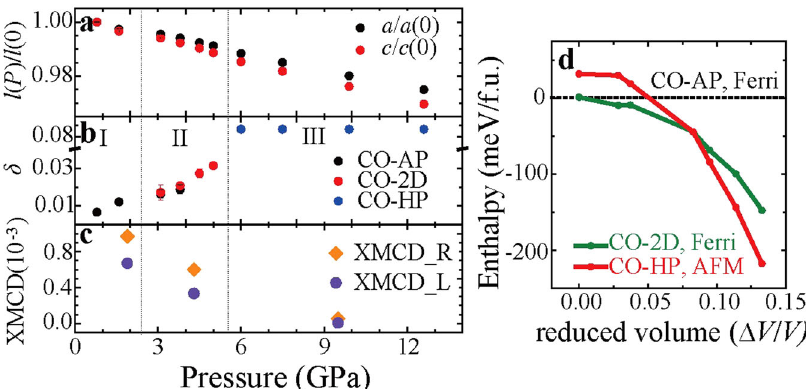
Fig. 4 Phase diagram of LuFe 2 O 4 under pressure. a Relative reduction of lattice parameters a and c by increased pressure measured between 0.8 and 12.6 GPa. b Evolution of in-plane incommensurate CO wave vector δ by pressure. δ is de fi ned by (1/3 + δ , 1/3 + δ ) in CO-AP and (1/3 − δ , 1/3 − δ ) in CO-2D. The commensurate CO wave vector (1/4, 1/4) of CO-HP is represented by δ = 1/12. c The pressure dependence of XMCD spectral weight. d The pressure dependence of relative enthalpies between the charge order phases mentioned in Figs. 2 and 3d – f. (ferri (ferrimagnetic), AFM